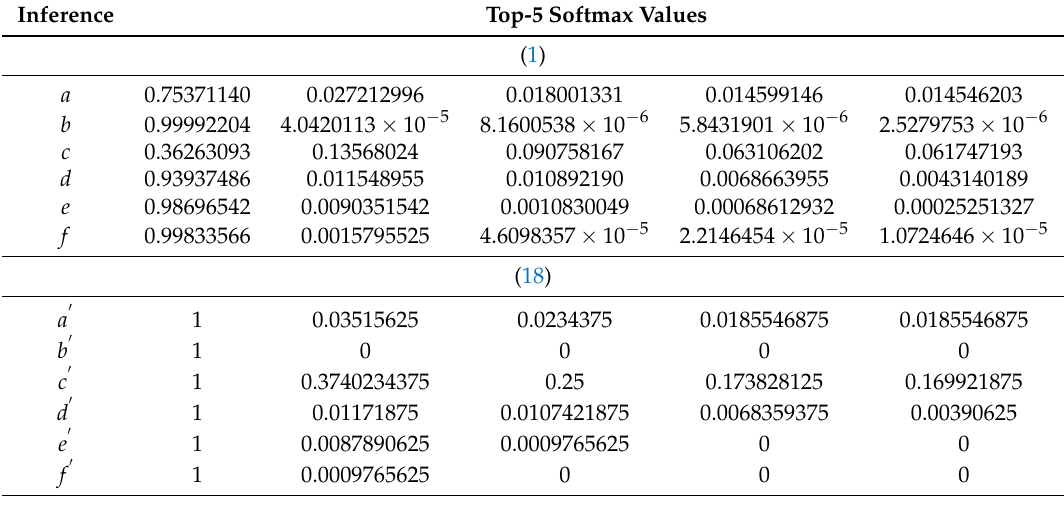
Table 1. Top-5 softmax values for six indicative inferences for each model. The actual softmax values and the proposed method values are obtained by (1) and (18), respectively. For the VGG-16 CNN, values obtained by (30) are also